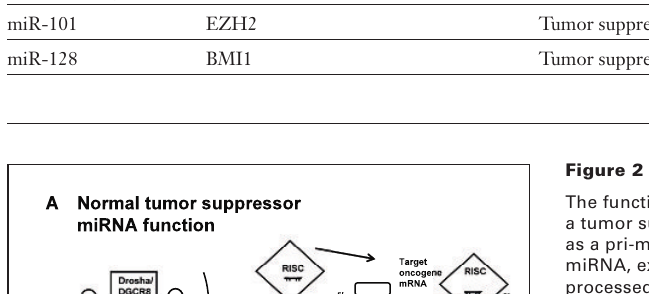
The function of tumor suppressor miRNAs. A, normally, a tumor suppressor miRNA is transcribed in the nucleus as a pri-miRNA, processed by Drosha/DGCR8 to a pre- miRNA, exported to the cytoplasm by Exportin-5/RanGTP, processed by Dicer and incorporated into RISC, which medi- ates translational repression and/or mRNA degradation of the target oncogene. B, decreased levels of a tumor sup- pressor miRNA, whether by genomic loss or epigenetic silencing as shown (processing defects and transcriptional blocks via trans acting factors may also occur), de-represses the target oncogene, leading to aberrant oncogene transla- tion and tumorigenesis. In the case of miR-101, genomic loss decreases miR-101, causing an increase in its target EZH2, which promotes